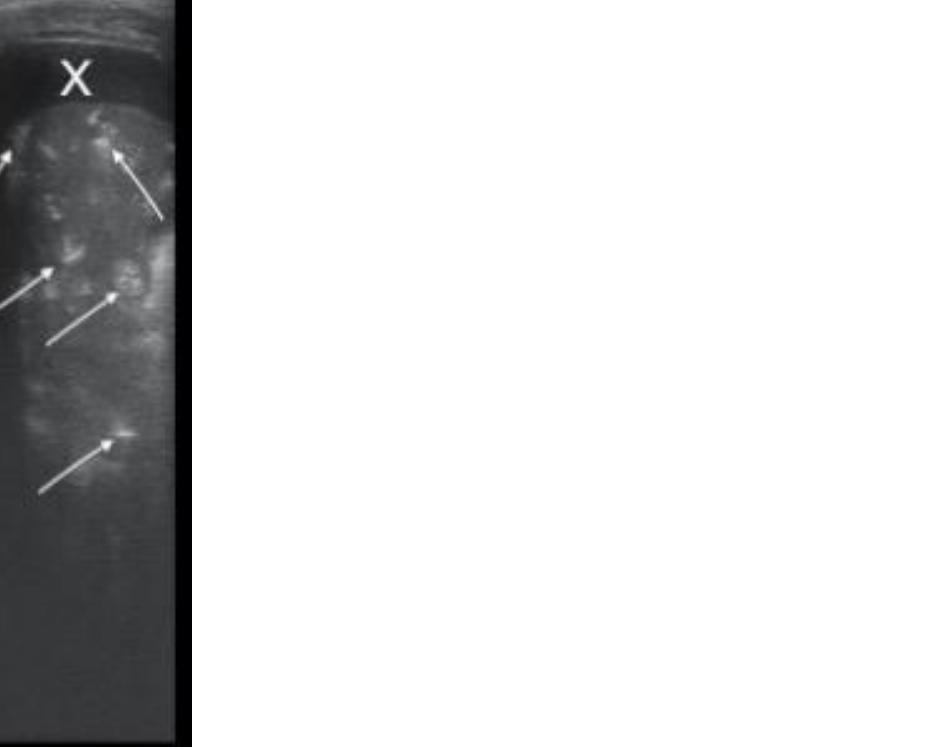
Figure 4. Consolidation with parenchymal structure and hyperechoic air (white arrows), showing the ventilation of the consolidation; adjacent pleural transonic effusion (X); 7 – 12 MHz, first day.